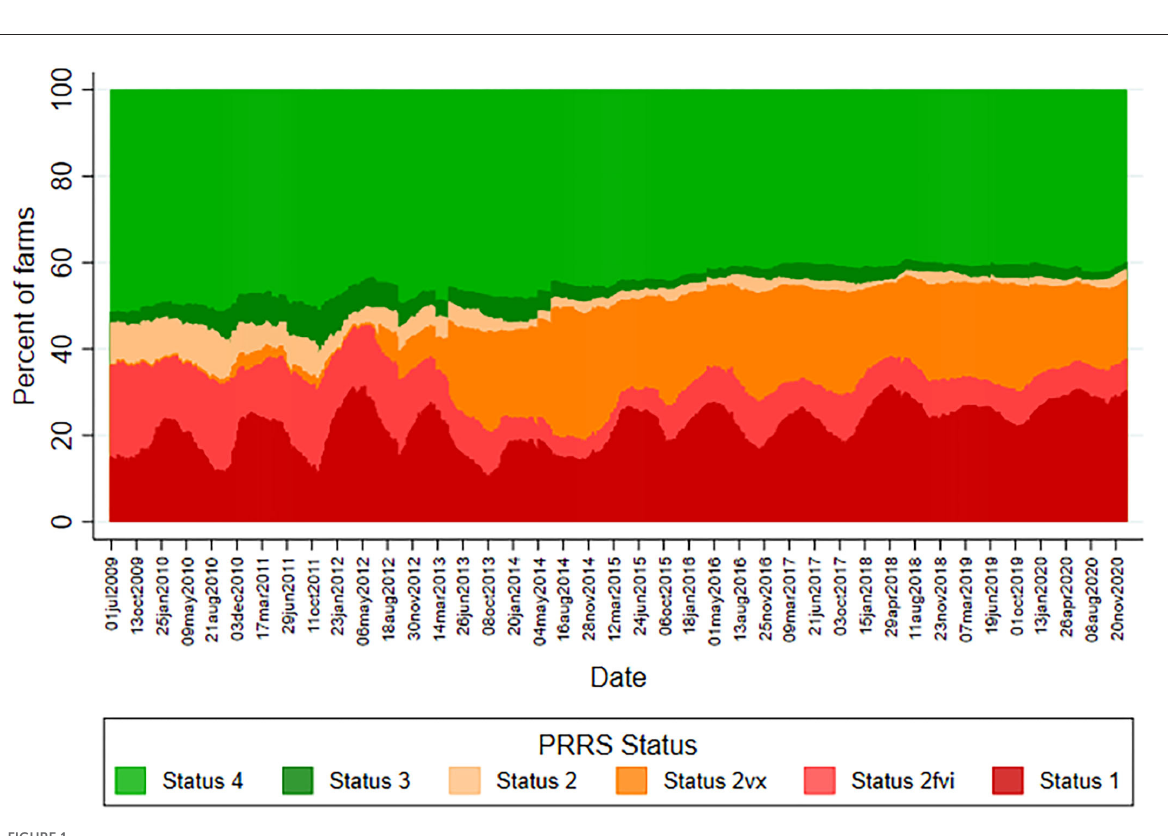
2018, a median of 1,544 (ranging from 1,106 to 1,958) processing fluids samples were submitted monthly for